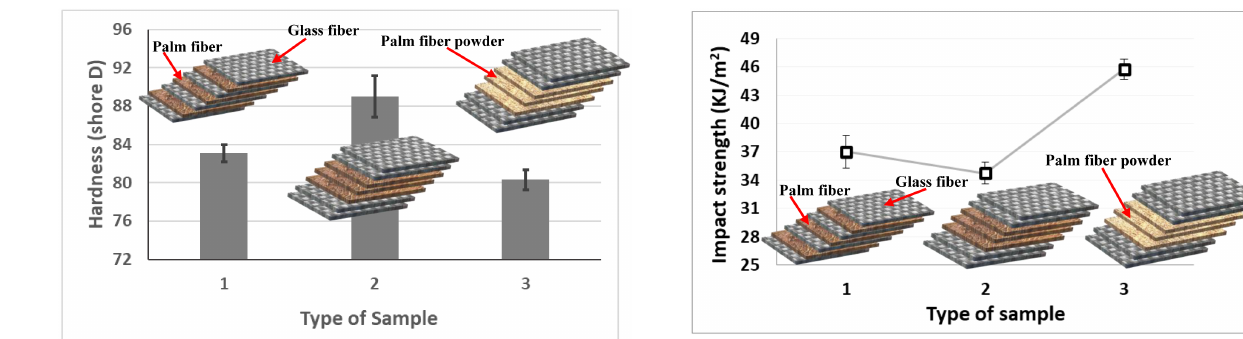
Fig. 5. The influence of fiber layers (arrangement and form) on the hardness.